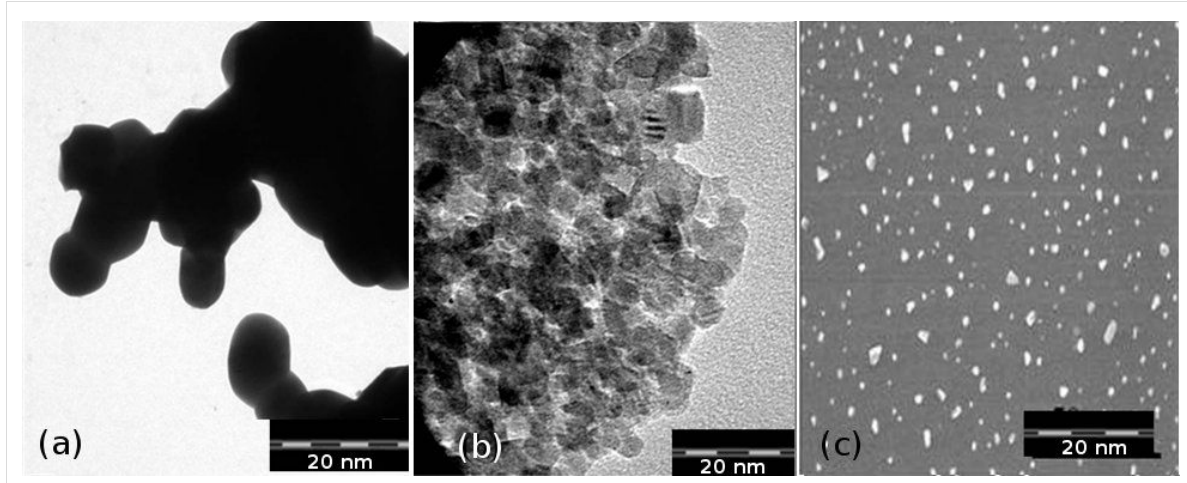
Figure 2: TEM images of (a) TiO 2 and (b) 3% and (c) 7% Ag-doped TiO 2 nanoparticles annealed at 450 °C.